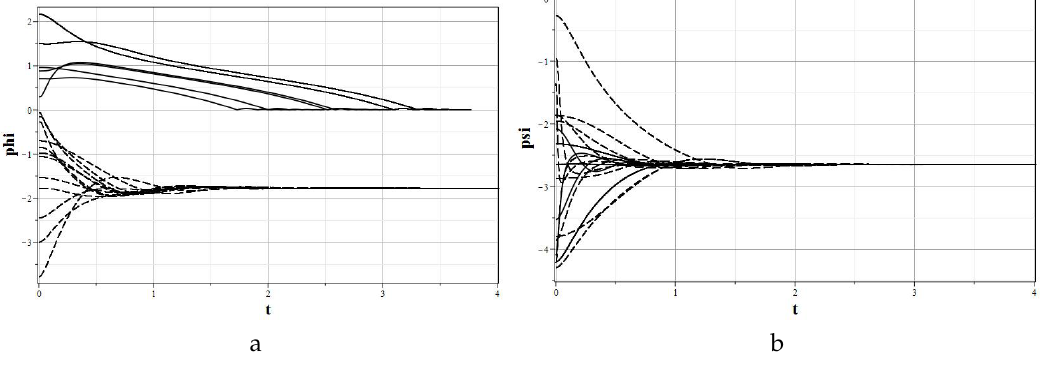
Figure 8. Dependence on t of the fields φ ( a ) and ψ ( b ).